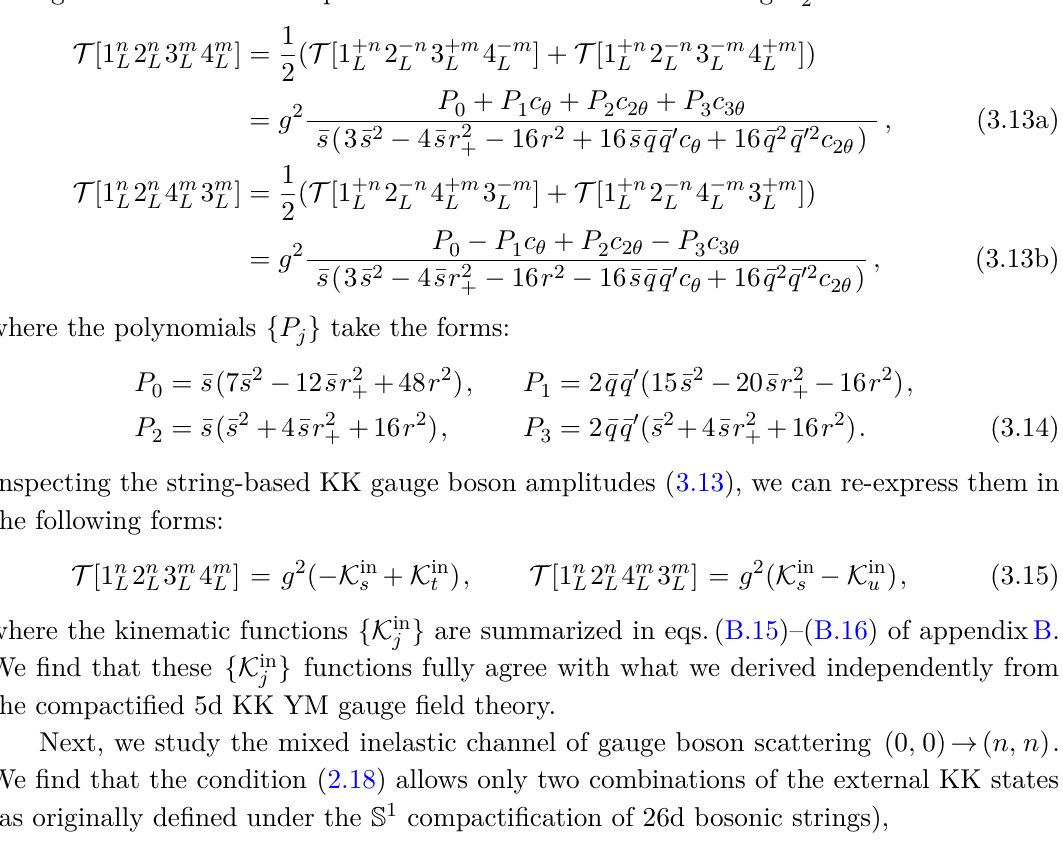
Figure 3 . Inelastic scattering amplitudes of (0 , 0) → ( n, n ) for massive KK open string with Z even parity (blue color) can be decomposed into a sum of two sub-amplitudes of massive KK open strings (red color) under the S 1 compactification of 26d for bosonic